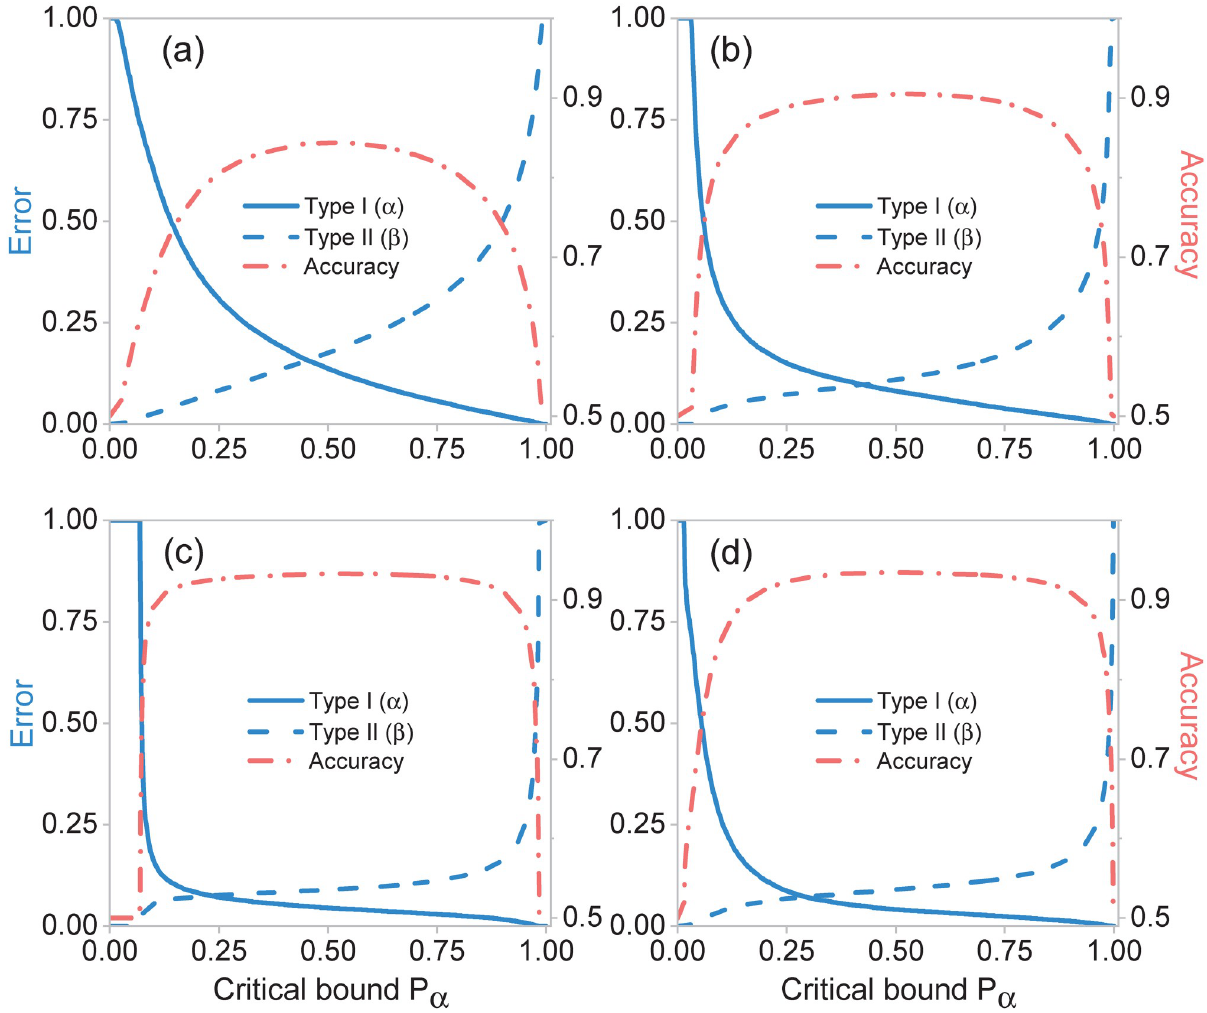
Fig 4. Type-I ( α ) and Type-II ( β ) errors, and accuracies for different clinical stages (a) Stage 1, (b) Stage 2, (c) Stage 3, and (d) Stage 4. Overall accuracy and errors are obtained from the hypothesis testing method as a function of critical bound p α , using the neural network outputs as